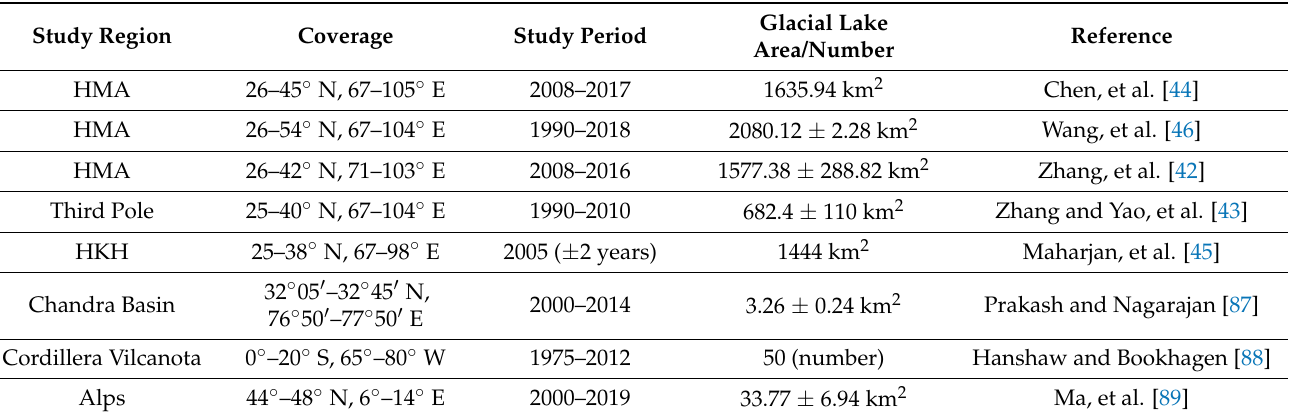
Table 5. Previous glacial lake studies conducted in high-mountain